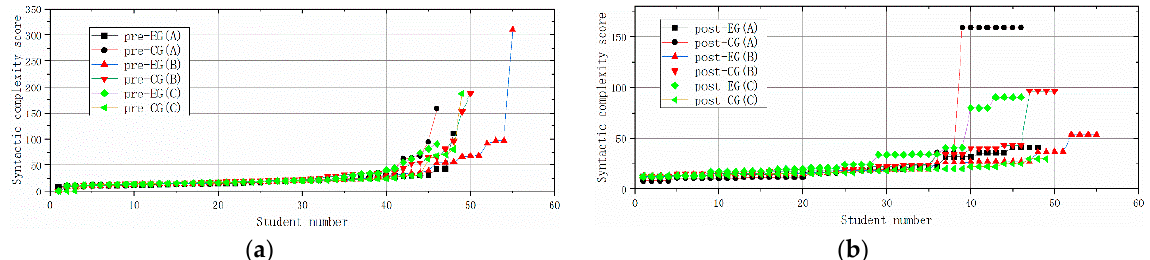
Figure 8. Comparison of pre-and posttests scores. ( a ) Comparison of pretest syntactic complexity. ( b ) Comparison of posttest syntactic complexity.